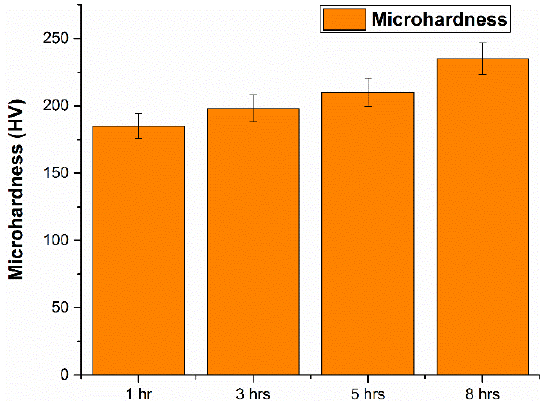
Figure 8. Microhardness values of sintered samples at varying dwell times.